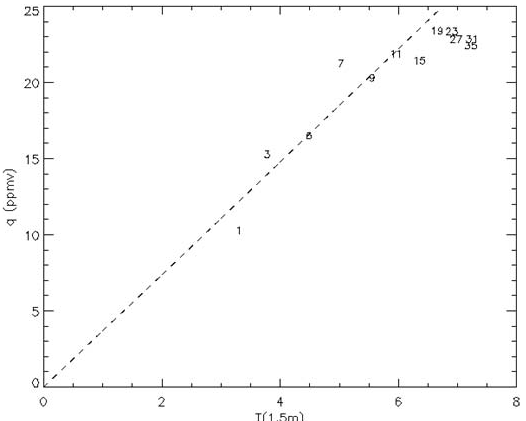
Fig. 8. Stratospheric Water Vapour at 60hPa in LEP2 vs surface temperature during the transient-warming phase of the integration. The temperature values have had the time-mean value in run LEP1 subtracted from them (as in Fig. 7). The dashed line corresponds to the linear regression Y=3.75T